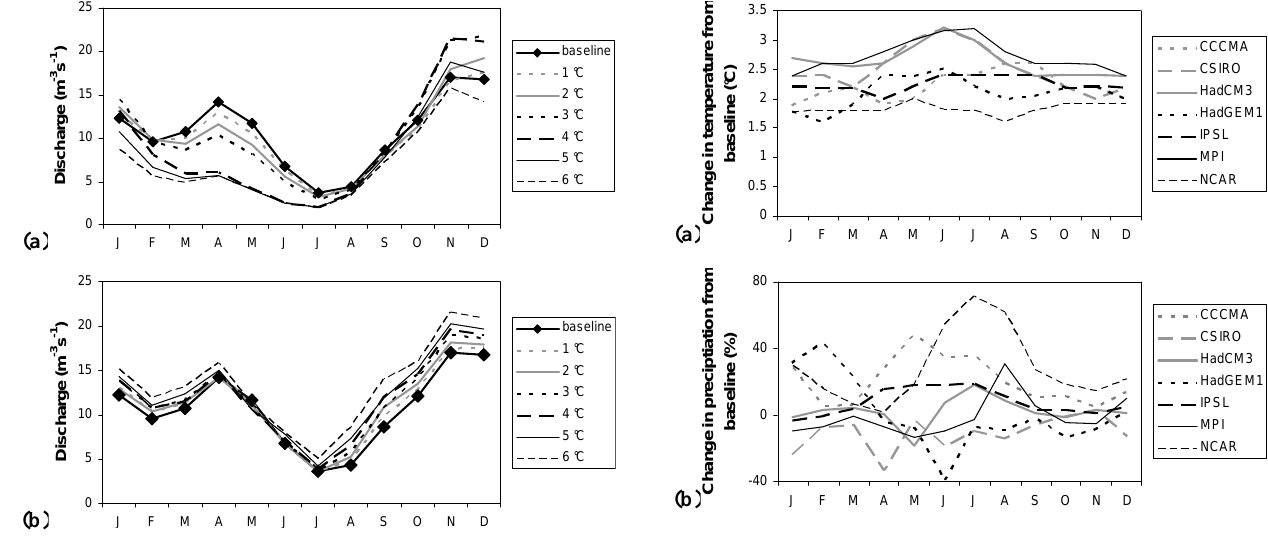
Figure 6 Fig. 6. (a) Temperature and (b) precipitation only climate change signals in River Mitano discharge under HadCM3 prescribed warm- ing scenarios.